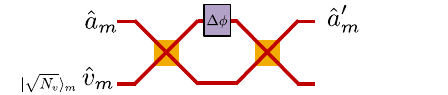
FIG. 9. Schematic of conversion between phase shift and displacement through a Mach-Zehnder